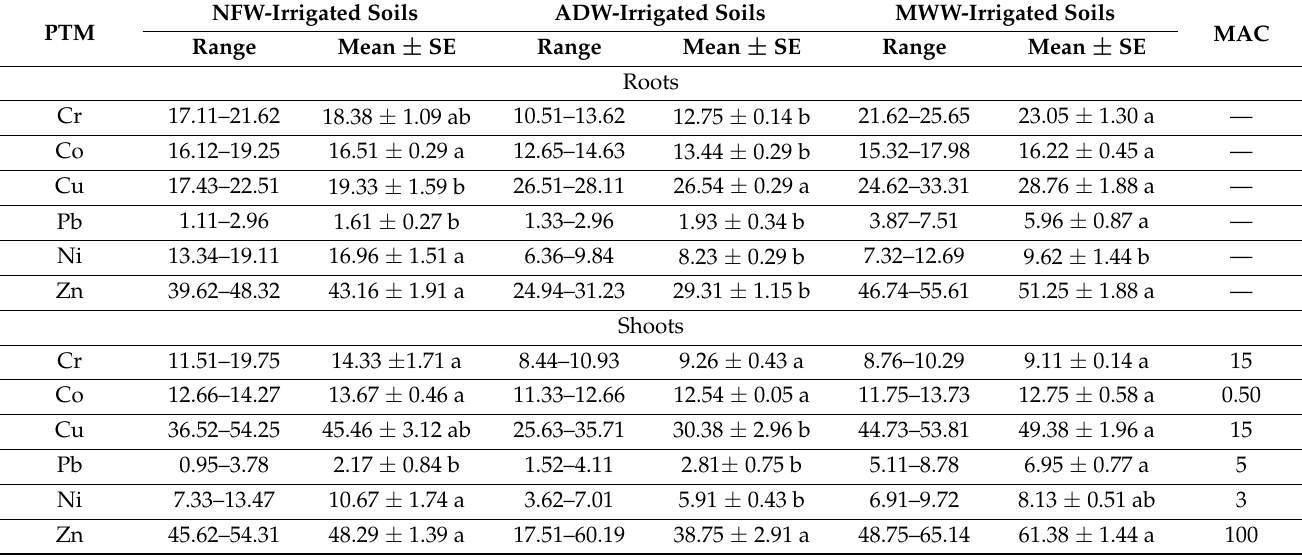
Values are means ± standard error (SE) of ten soil samples; means with different letters indicate significant difference at 0.05 probability level; NFW, Nile freshwater; ADW, agricultural drainage water; MWW, mixed wastewater.bdl, below detection limit; SE, standard error; MAC, maximum allowable concentration (FAO 29